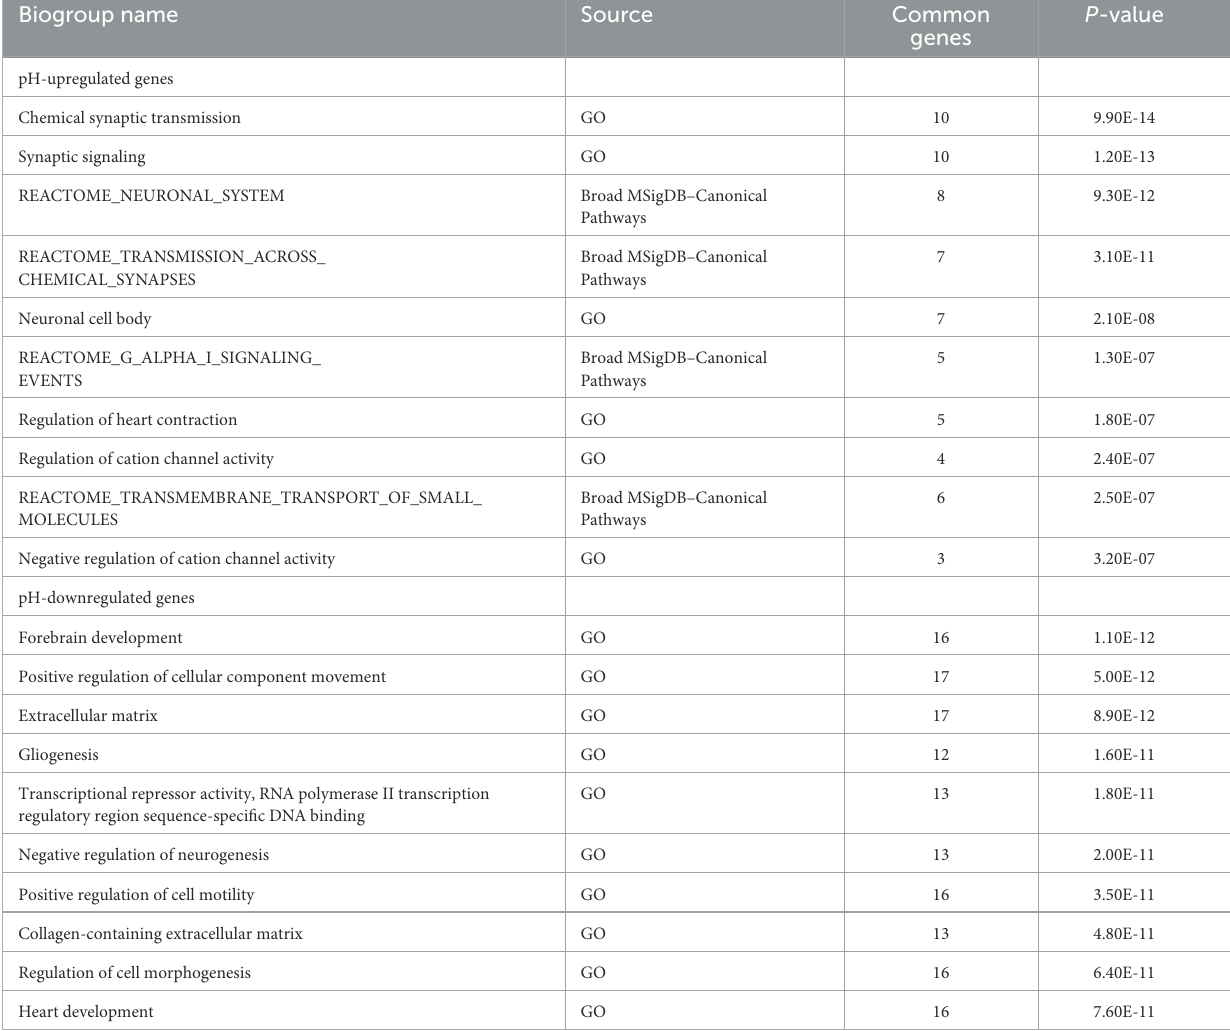
TABLE 1 Pathway enrichment analysis of pH-up/downregulated